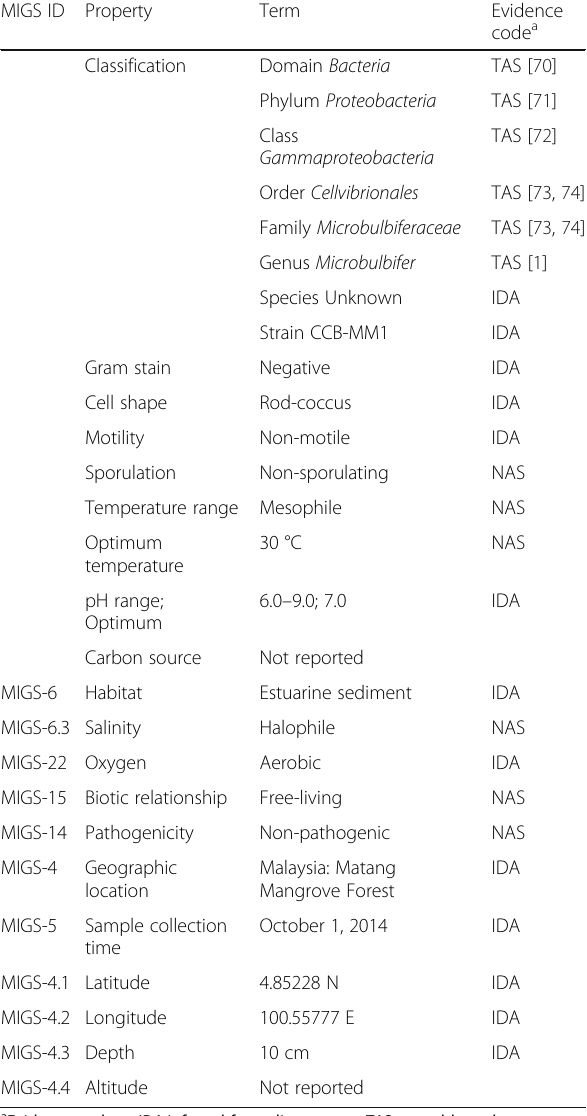
Table 1 Classification and general features of Microbulbifer